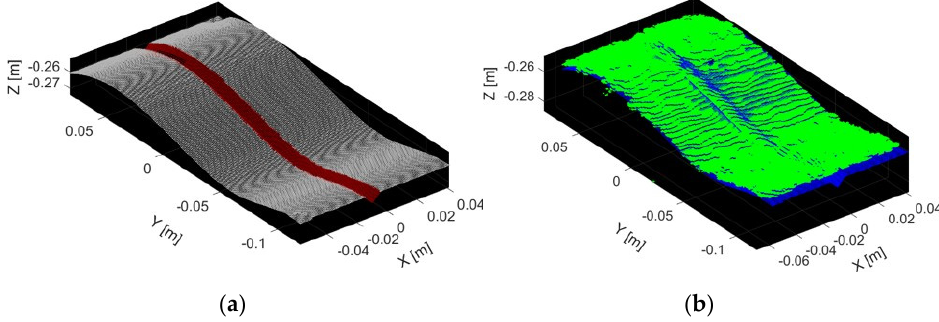
Figure 6. 3D Reconstruction evaluation: ( a ) target point cloud; ( b ) the result of ICP color registration between target and 3D. between target and 3D.